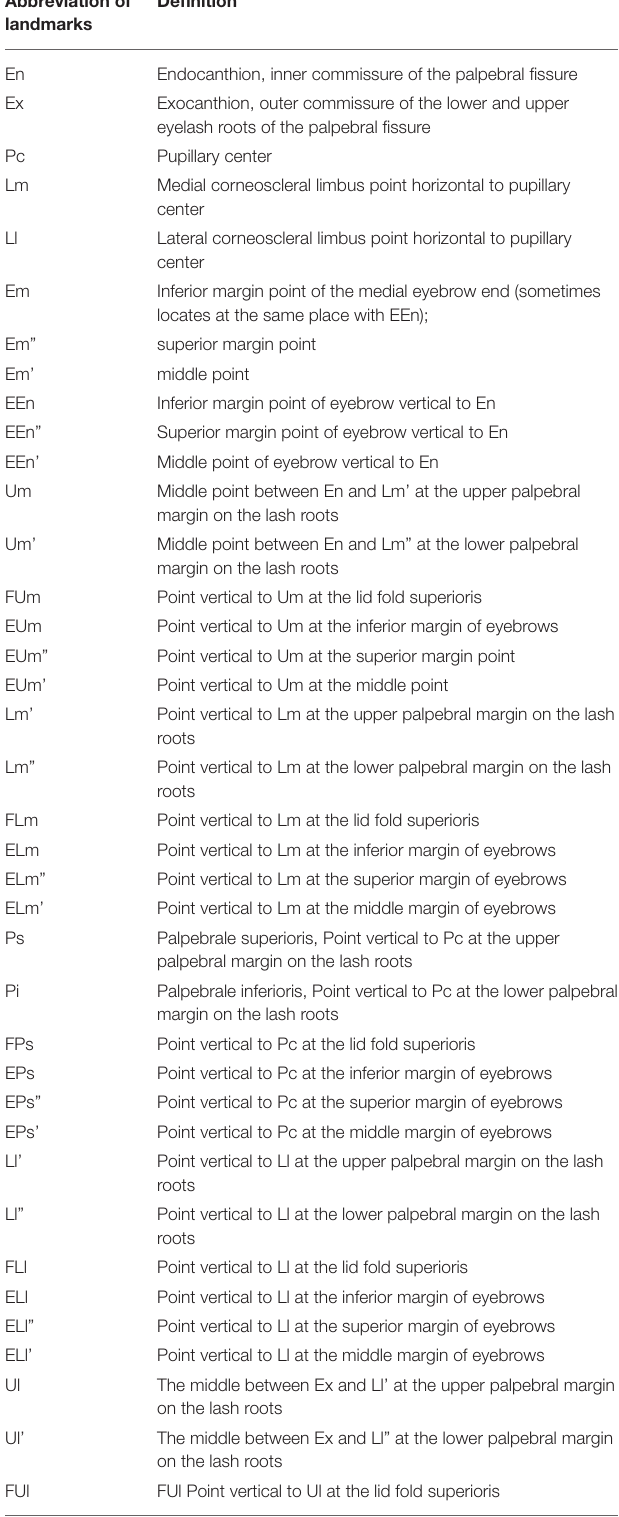
TABLE 1 | Definition of abbreviations for periocular landmarks, modified from Guo et al. (17). Abbreviation of